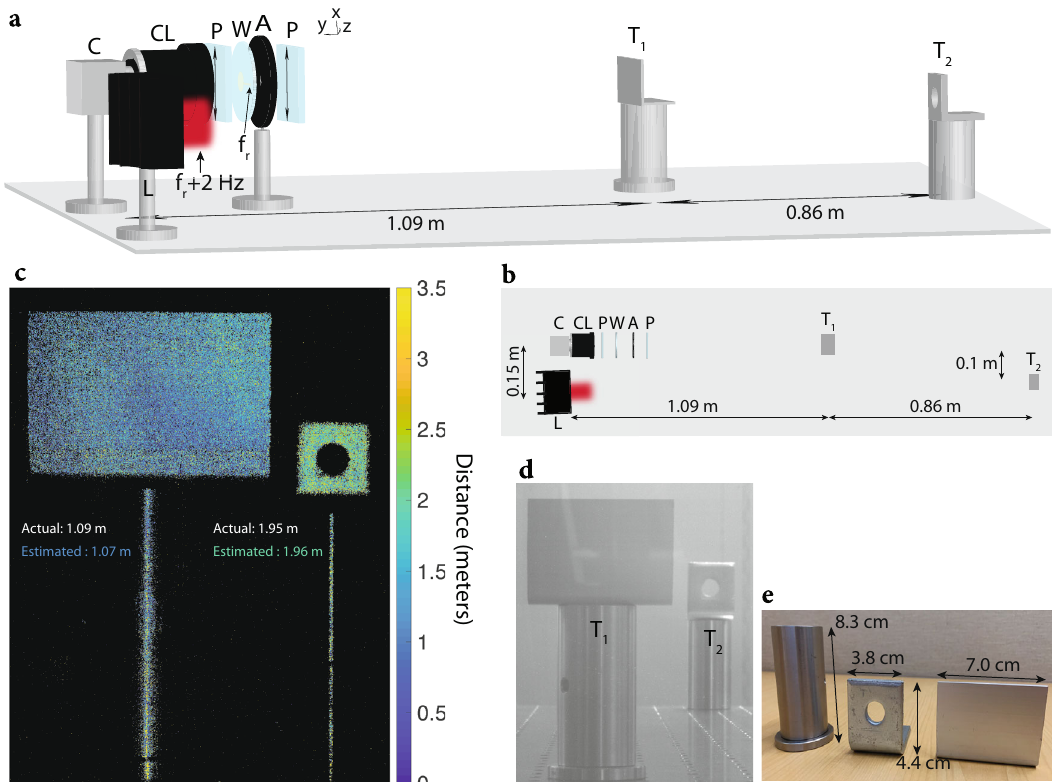
Fig. 3 ToF imaging using the modulator and a standard camera. a Schematic of the imaging setup is shown. The setup includes a standard CMOS camera ffiffiffi p (C), camera lens (CL), two polarizers (P) with transmission axis ^ t ¼ ð ^ a x þ ^ a z Þ = 2 , wafer (W), aperture (A) with a diameter of 4 mm, laser (L) with a wavelength of 635 nm that is intensity-modulated at 3.733702 MHz, and two metallic targets ( T 1 and T 2 ) placed 1.09 m and 1.95 m away from the imaging system, respectively. For the experiment, 140 mW of RF power at f r = 3.7337 MHz is used to excite the wafer electrodes. The laser is used for illuminating the targets. The camera detects the re fl ected laser beam from the two targets, and uses the 2 Hz beat tone to extract the distance of each pixel corresponding to a distinct point in the scene (see “ Methods ” for more details). b Bird ’ s eye view of the schematic in ( a ). c Reconstructed depth map seen by the camera. Reconstruction is performed by mapping the phase of the beat tone at 2 Hz to distance using Eq. (3). The distance of each pixel is color- coded from 0 to 3 m (pixels that receive very few photons are displayed in black). The distance of targets T 1 and T 2 are estimated by averaging across their corresponding pixels, respectively. The estimated distances for T 1 and T 2 are 1.07 m and 1.96 m, respectively (averaged across all pixels corresponding to T 1 and T 2 ). d Ambient image capture of the fi eld-of-view of the camera, showing the two targets T 1 and T 2 . e The dimensions of the targets used for ToF imaging are